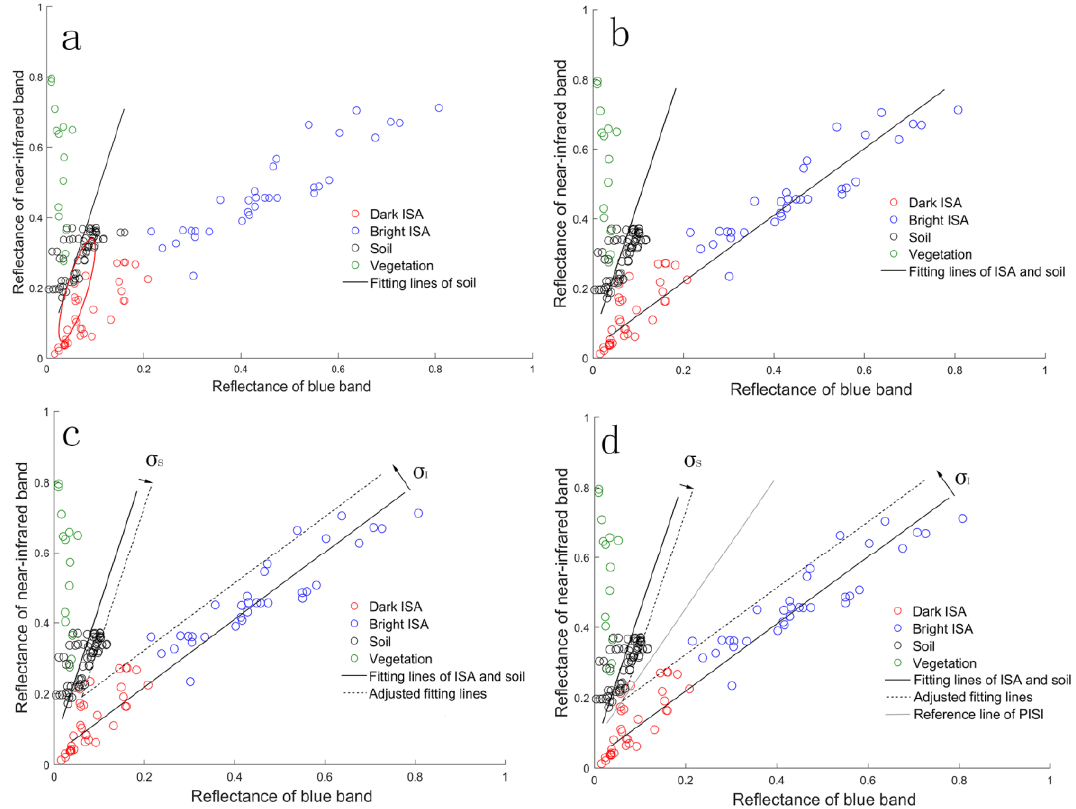
Figure 5. Establishment of reference line of PISI. ( a – d ) Represents the steps of establishment of reference line, respectively.